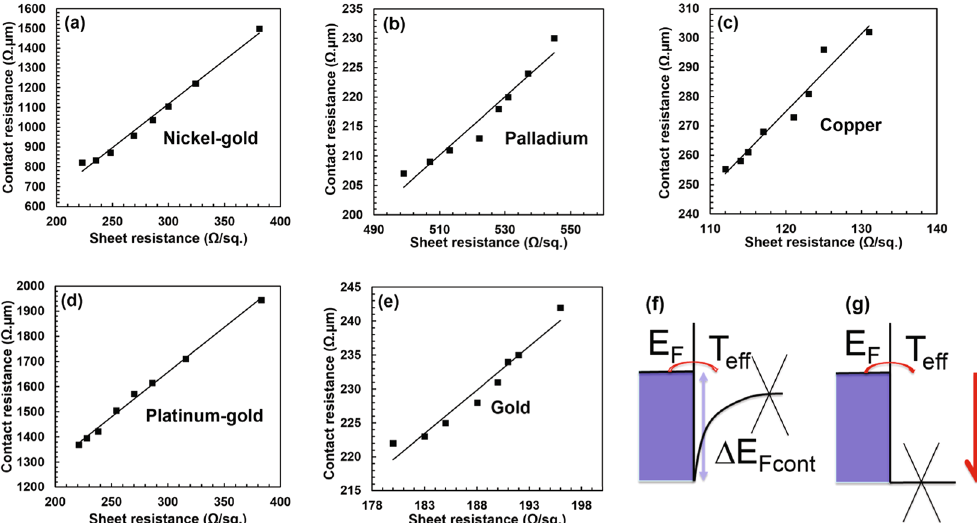
Figure 7. ( a–e ) Experiments: Plots of contact resistance vs. graphene sheet resistance for five different graphene-metal contacts (nickel/gold ( a ), palladium ( b ), copper ( c ), platinum-gold ( d ), gold ( e )). Each point corresponds to a different back-gate voltage V bg ( − 40 V, − 39 V, − 37 V, − 33 V, − 30 V, − 28 V, − 25 V, − 20 V). In all cases the correlation coefficient of the linear fit is very high ( R > 0.96), confirming our interpretation. ( f ) Illustration of the simple model of graphene-metal contact and ( g ) condition of minimum contact resistance, obtained by properly adjusting the graphene Dirac point near the contacts.